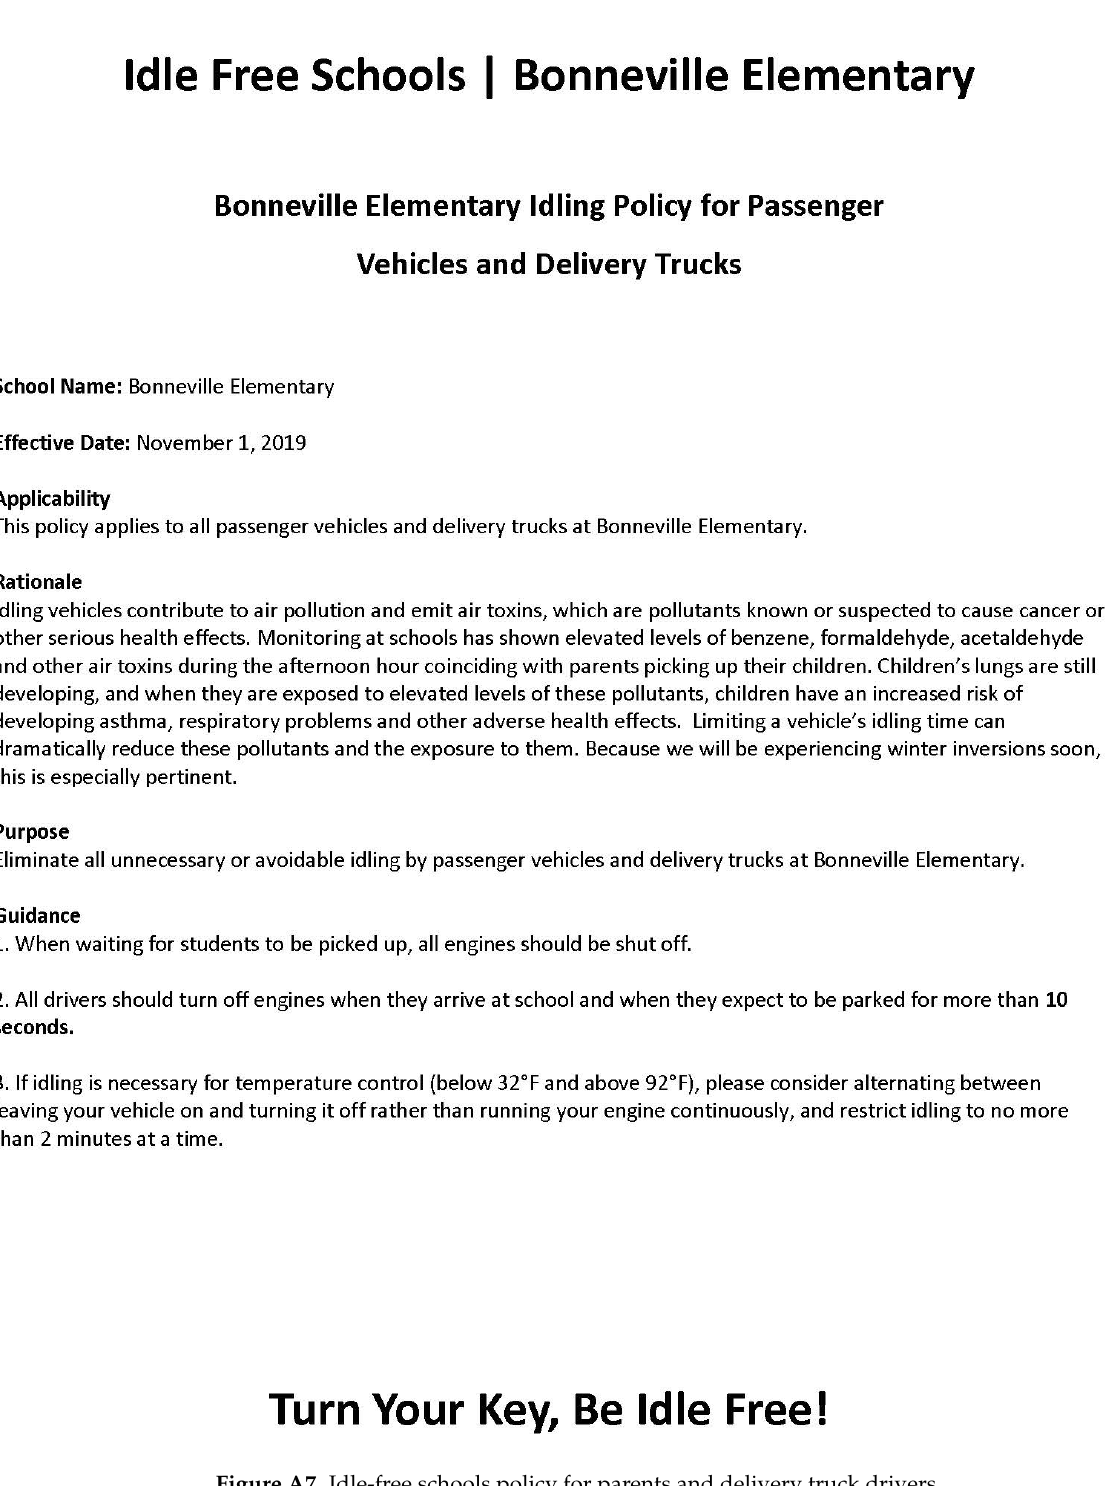
Figure A7. Idle-free schools policy for parents and delivery truck drivers.